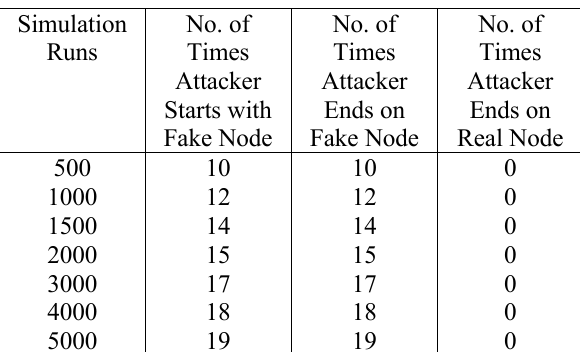
Table 4. Performance evaluation table for fake to fake